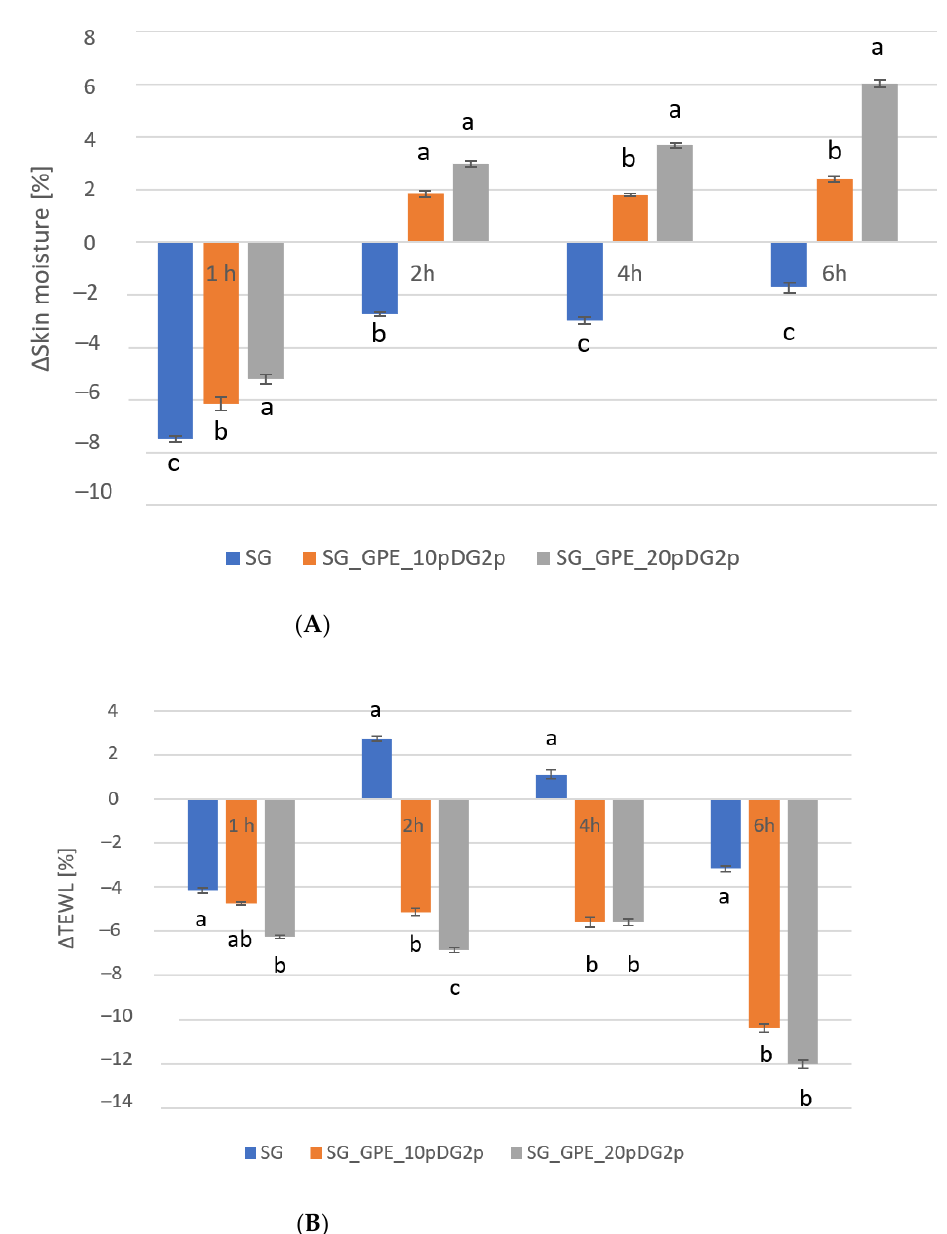
Figure 7. Influence of plant extracts on skin hydration ( A ) and TEWL ( B ). The superscripts a, b and c denote significant ( p < 0.05) differences between the test extracts within the individual test times.